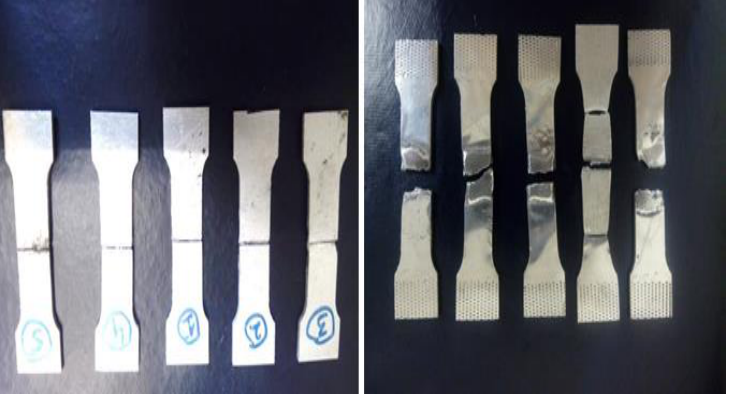
Figure 7. Specimen for tensile testing.